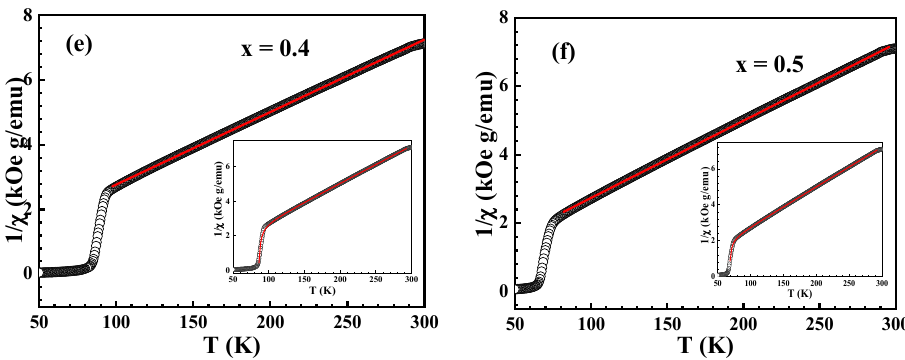
Figure 7. ( a – f ): Inverse magnetic susceptibility versus temperature plots of GECMO series measured at 100 Oe applied magnetic field. Open circles represent the experimental data points whereas solid lines of plot display the fitting to the Curie–Weiss law. Insets represent the fitting of inverse magnetic susceptibility versus temperature using Equation (4).